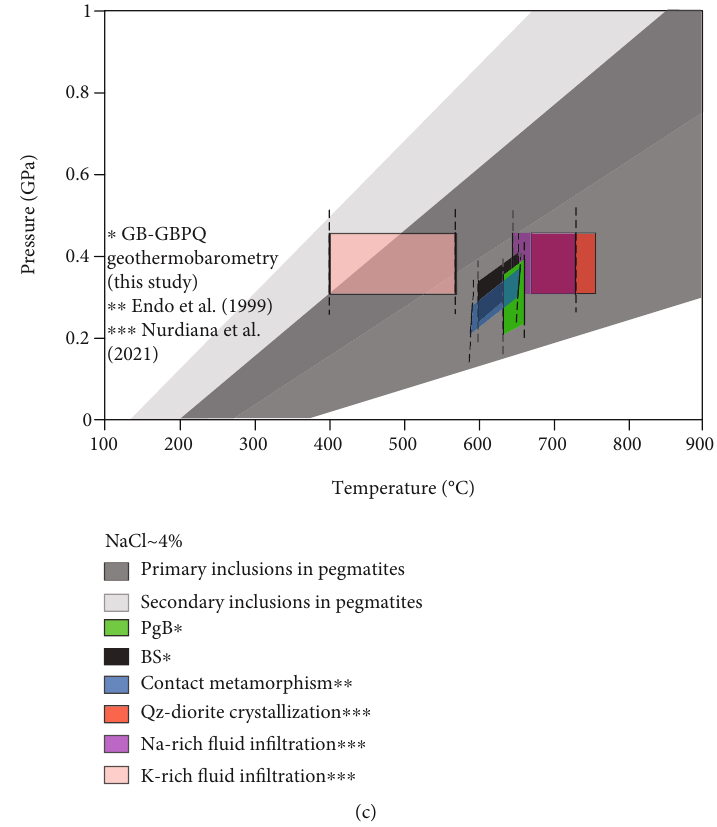
Figure 8: Pressure – temperature conditions of quartz diorite crystallization, biotite schist metamorphism, and pegmatite in fi ltration. (a) Photomicrograph of fl uid inclusions at room temperature. Two-phase primary inclusions and a planar array of secondary fl uid inclusions occur in quartz in sample PgD. (b) Measured homogenization temperatures of fl uid inclusions in quartz in the pegmatites. (c) Conditions of pegmatite formation as indicated by the shaded area from the isochores of the homogenization temperature range. The metamorphic conditions are based on GB and GBPQ geothermobarometry. The conditions of quartz diorite crystallization and pegmatite in fi ltration are from Nurdiana et al. [24]. PgD: Qz diorite-hosted pegmatite primary inclusions; PgD-s: Qz diorite-hosted pegmatite secondary inclusions; PgC: Cpx schist-hosted pegmatite primary inclusions; PgB: Bt schist-hosted pegmatite primary inclusions; PgB-s: Bt schist-hosted pegmatite secondary